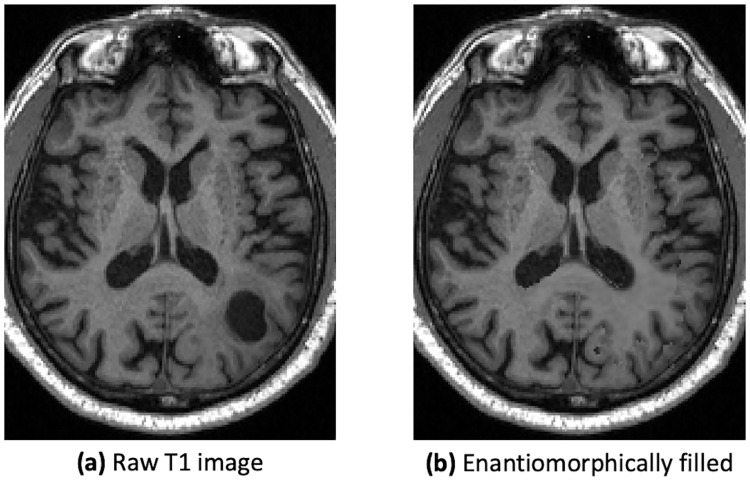
An example of the enantiomorphic filling of the brain tumor.The enantiomorphically filled image was only used for the freesurfer parcellation, as tumors can lead to problems during the fitting process.